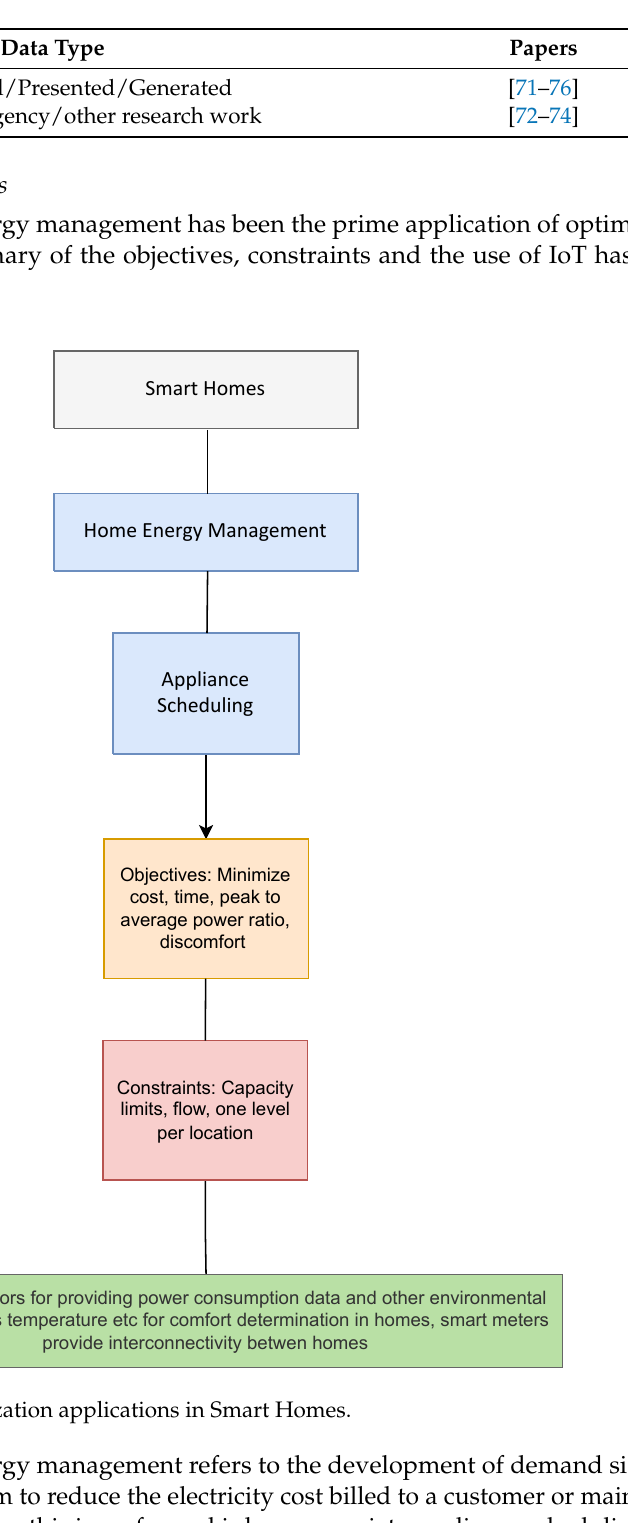
Table 8. Data setup used for Smart Health